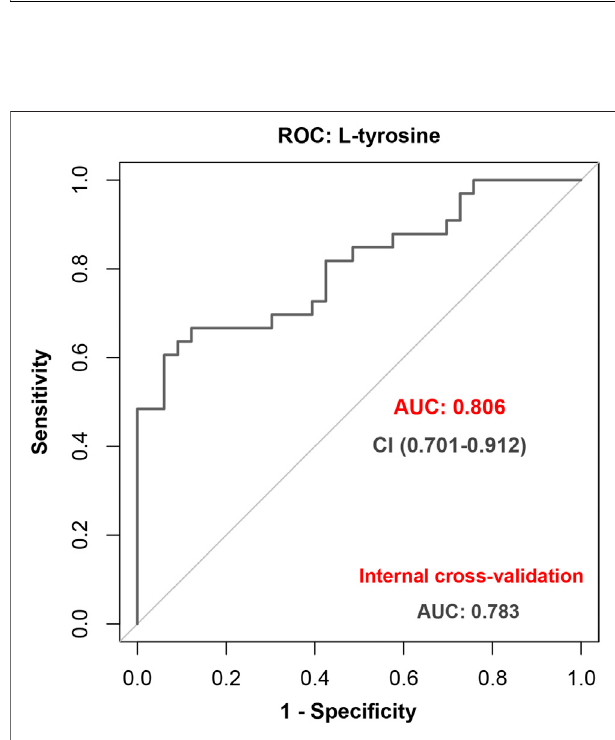
FIGURE 4 | Performance of L-tyrosine to predict emergence agitation (EA) with the receiver operating characteristic (ROC) analysis and further internal